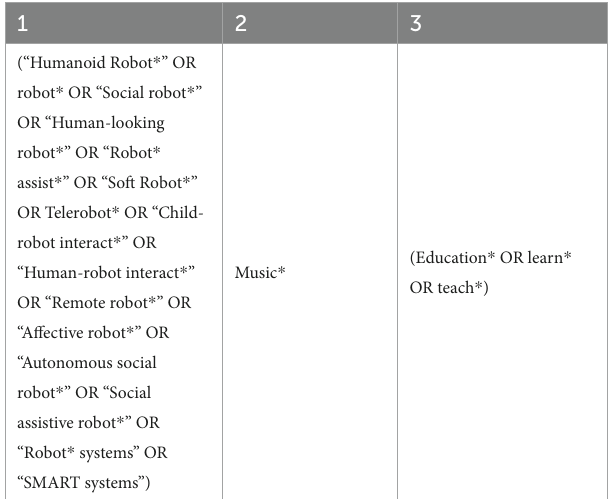
TABLE 1 List of descriptors used in the systematic review.